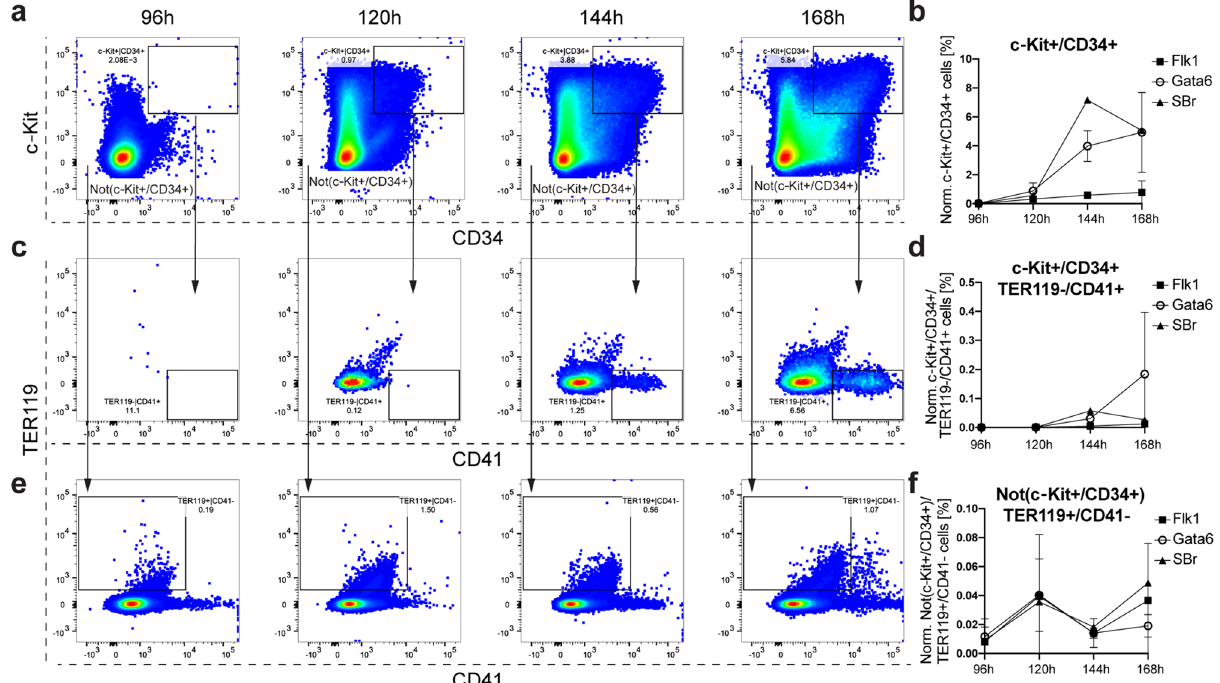
Figure 2. Emergence of hematopoietic and erythroid progenitors in gastruloids. ( a ) Representative flow cytometry plots and ( b ) relative quantification of the emergence of the c-Kit + /CD34 + populations in gastruloids from 96 to 168 h. The c-Kit + /CD34 + population was gated further for TER119 − /CD41 + populations, with ( c ) representative flow cytometry plots and ( d ) relative quantification. We refer to the remaining cells after gating for c-Kit + /CD34 + cells as Not(c-Kit + /CD34 + ). Notably, the Not(c-Kit + /CD34 + ) population still contains single positive cells for c-Kit and CD34. The Not(c-Kit + /CD34 + ) population was additionally gated for TER119 + / CD41 − , with ( e ) representative flow cytometry plots and ( f ) relative quantification. The graphs in ( b , d , f ) show the changes in the percentage of positive cells over time. Flk1-GFP (Flk1) (n = 2 replicates), Gata6-Venus (Gata6) (n = 2 replicates) and Sox1-GFP::Brachyury-mCherry (SBr) (n = 1 replicate). Data are represented as mean ±